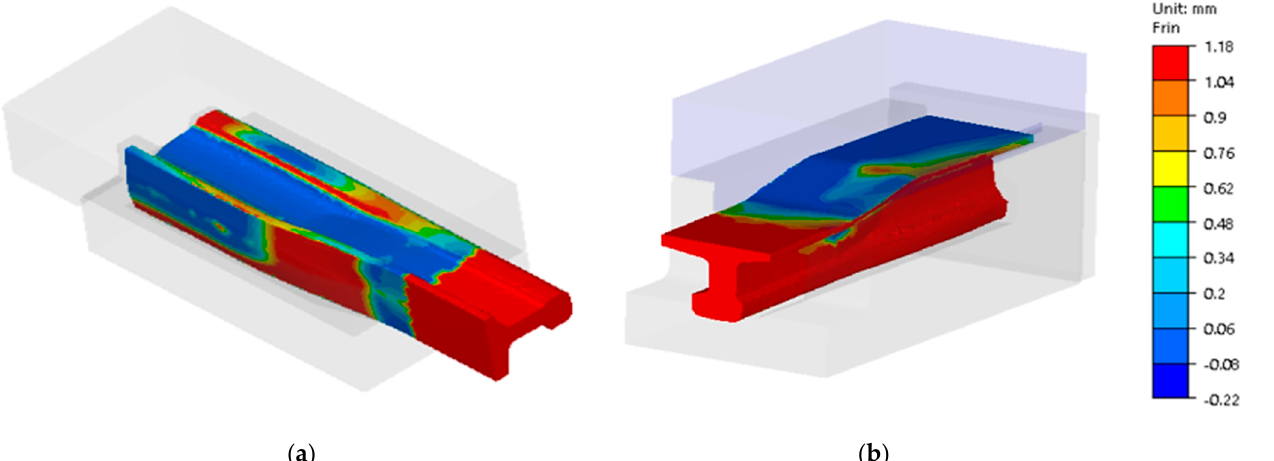
Figure 5. Results of contact for forging: ( a ) after operation I, ( b ) after operation II, blue colour means full contact between forming material and tool.